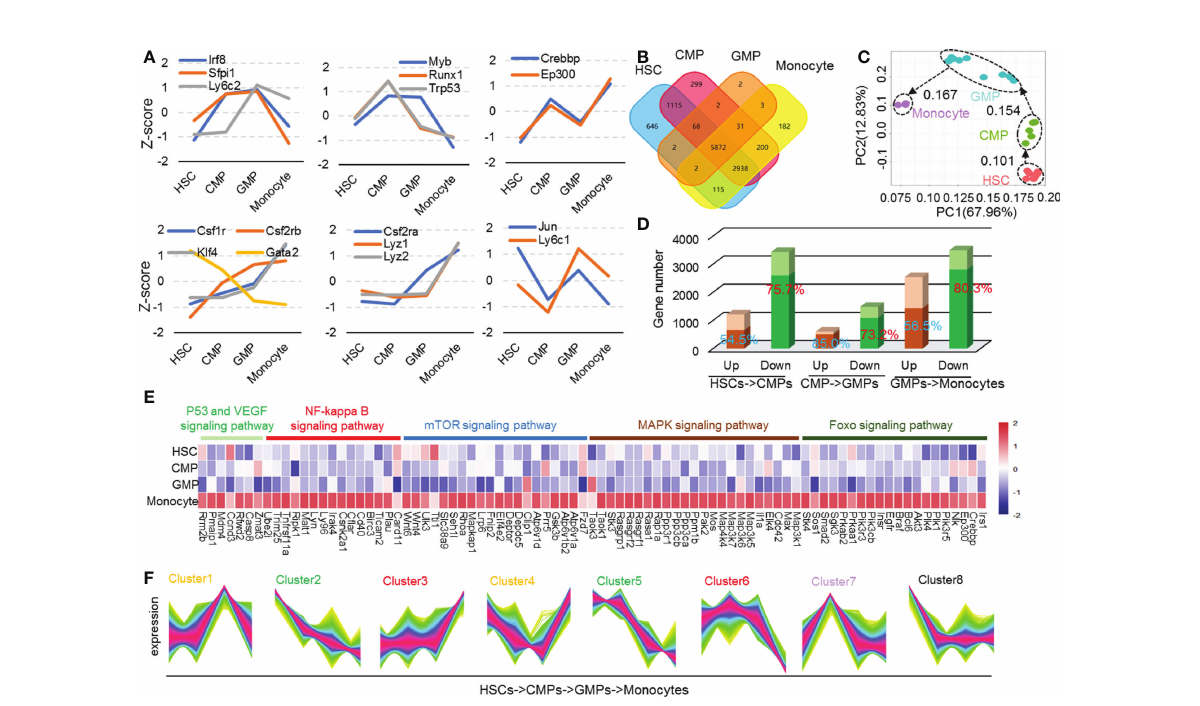
FIGURE 1 Differential gene function analysis and transcriptional regulation modes in mouse monocyte development stages. (A) The Z-score was used to depict the expression of conclusive molecular and transcriptional factors during mouse monocyte development. (B) Venn plots of mouse HSCs, CMPs, GMPs, and monocytes expression genes. The expression genes are de fi ned as TPM > 0.1. (C) Population-distance analysis of genes shown in two principal components (PC1 67.96%, PC2 12.83%). Cell types are color coded, labeled by name, and surrounded by different ellipses: HSCs, red; CMPs, green; GMPs, blue; monocytes, purple. (D) The bar plot represents differential genetic statistics of mouse monocyte developmental phases. The bars in darker color represent the RNA-seq data measured in our own laboratory, and the entire master composed of dark and light bars represents the number of differential genes identi fi ed by the downloaded data. (E) Heatmap of upregulated genes in HSCs, CMPs, GMPs, and monocytes in P53, NF-kappa B, MAPK, mTOR and Foxo signaling pathways. (F) The line chart is the different regulation mode of expression genes in mouse monocyte development